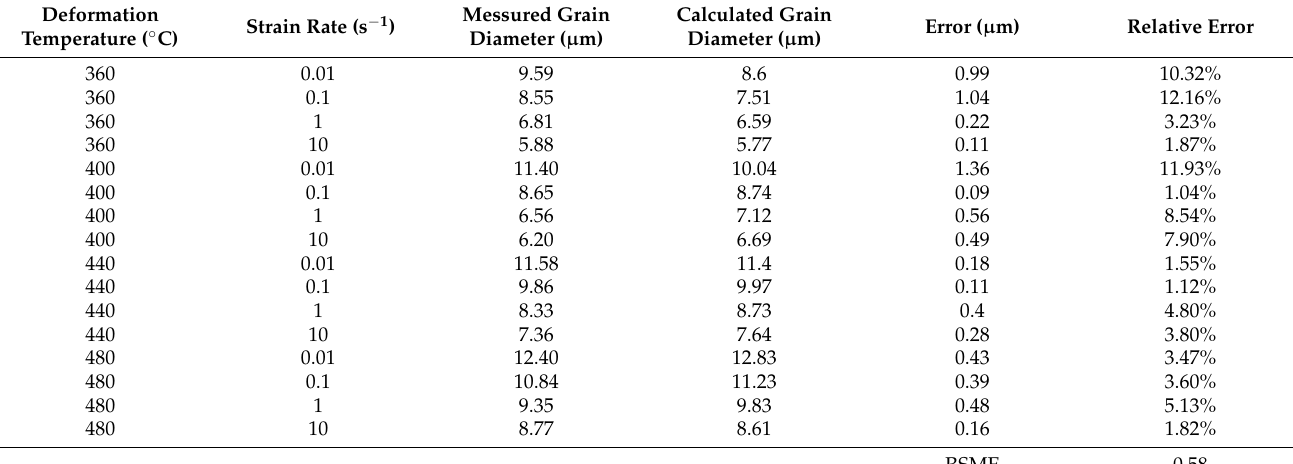
According to Equation (13) we can obtain the calculated grain size as Table 4: Table 4. Calculated recrystallization grain size in Equation Table 4. Calculated recrystallization grain size in Equation (13).